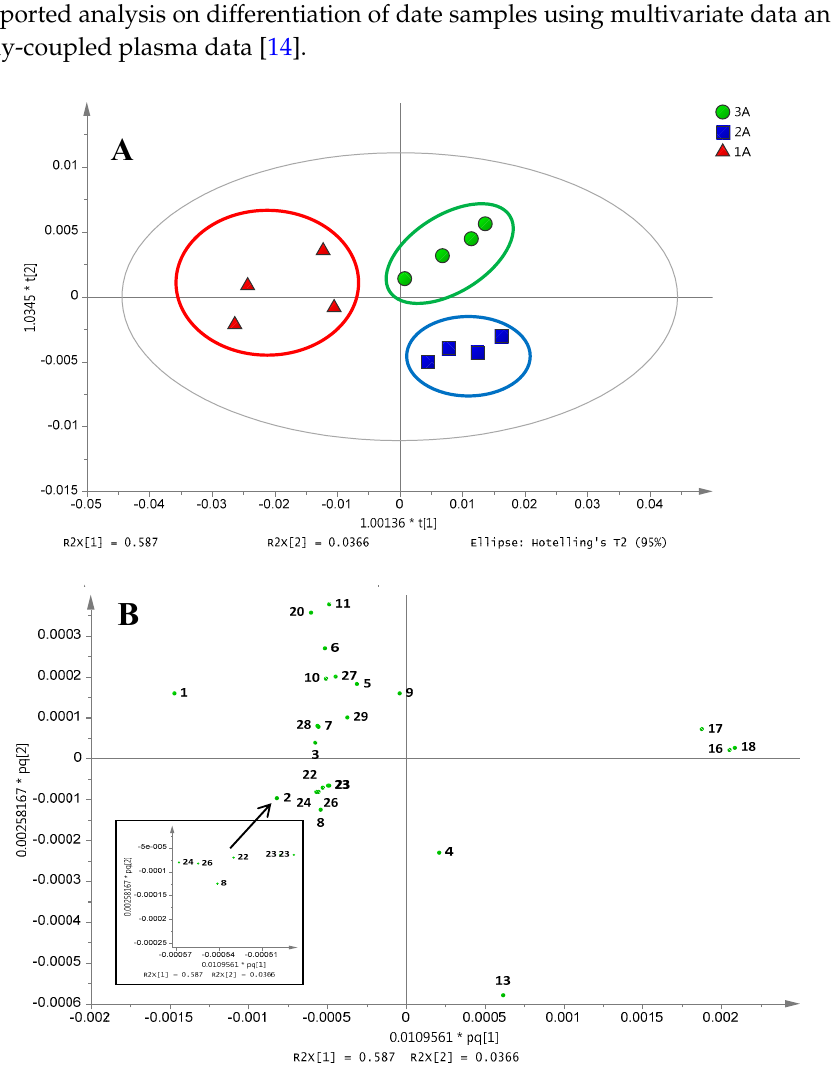
Figure 3. ( A ) The OPLS-DA score plot; ( B ) loading score plot of different grades of Ajwa dates from